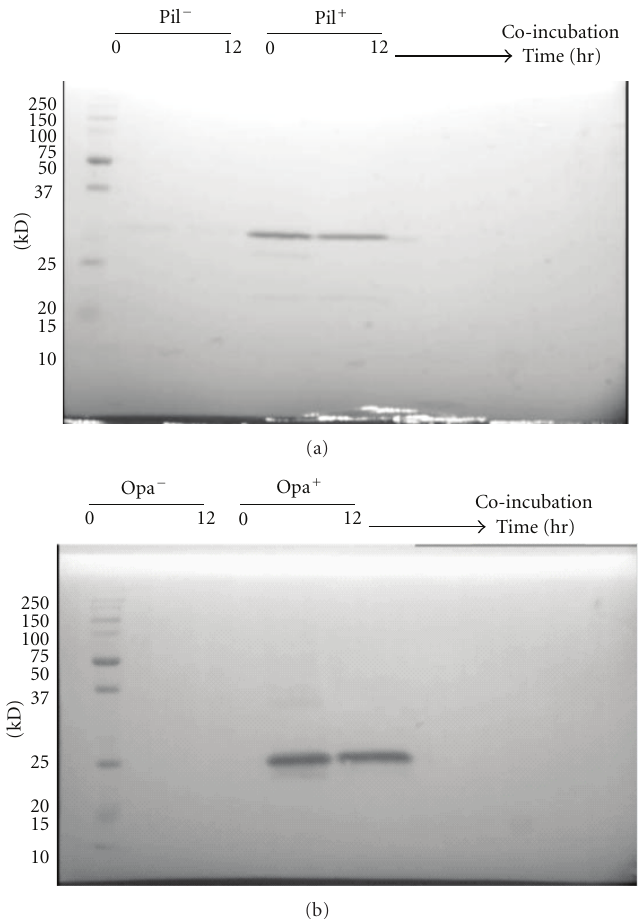
Figure 2: Western blot for Pil and Opa proteins in Pil + Opa + and Pil − Opa − gonococcal strains incubated for 12h with Fallopian tube mucosal strips. (a): Western blot for Pil protein. (b): Western blot for Opa protein. The two dark bands corresponding to Pil (a) and Opa (b) appear in lanes from the Pil + Opa + strain only. Densitometry analysis showed no change in Pil and Opa expression after the co-incubation.